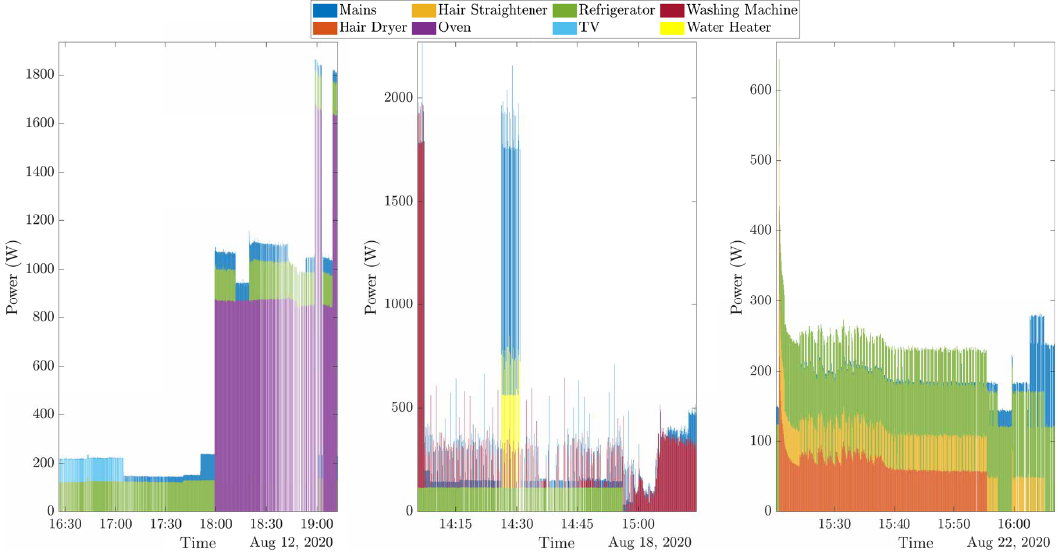
Figure 10. WP electricity consumption of household 5 annotated using IL ground-truth